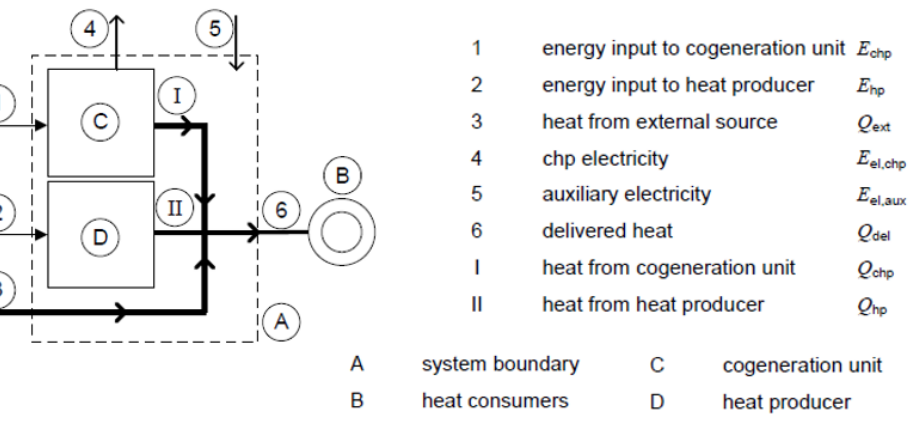
Figure 1. Ecoheat4cities analysis boundaries [13].